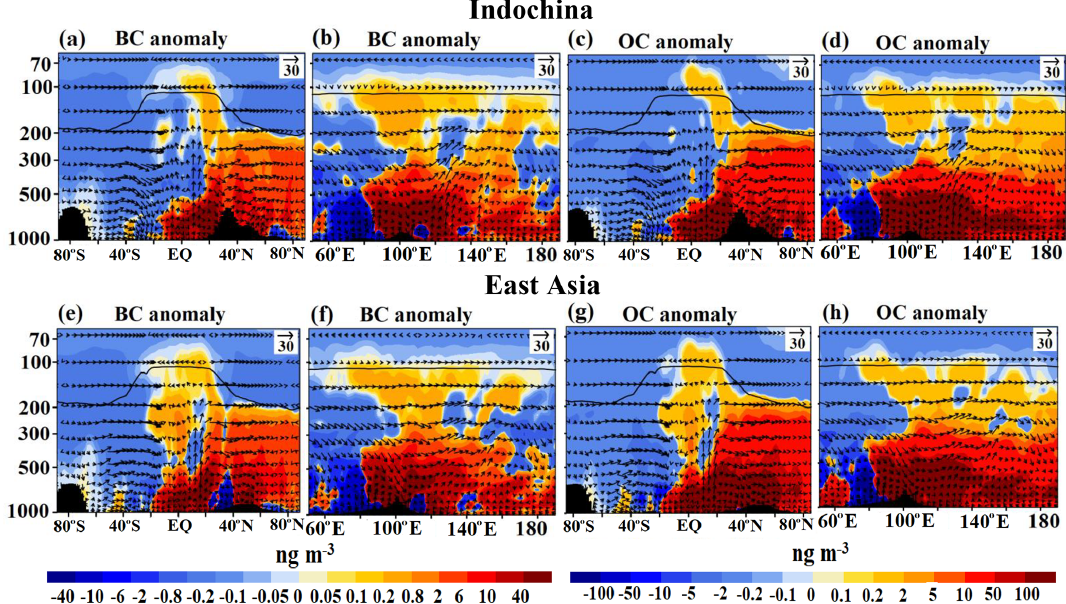
Figure 6. Vertical cross section of anomalies of BC (ngm − 3 ) (BMaeroon–Bmaerooff) averaged for the spring 2013 (a) latitude–pressure section (averaged for 91–107 ◦ E) and (b) longitude–pressure section (averaged for 18–24 ◦ N). (c–d) Same as (a) – (b) but for OC. (e) Same as (a) but averaged over 108–123 ◦ E and (f) same as (b) but averaged for 18–24 ◦ N. (g–h) Same as in (e) – (f) but for OC. The arrows in (a) – (h) indicate winds in ms − 1 , with the vertical velocity field scaled by 300. The black vertical bars show the topography, and the black line indicates the tropopause.